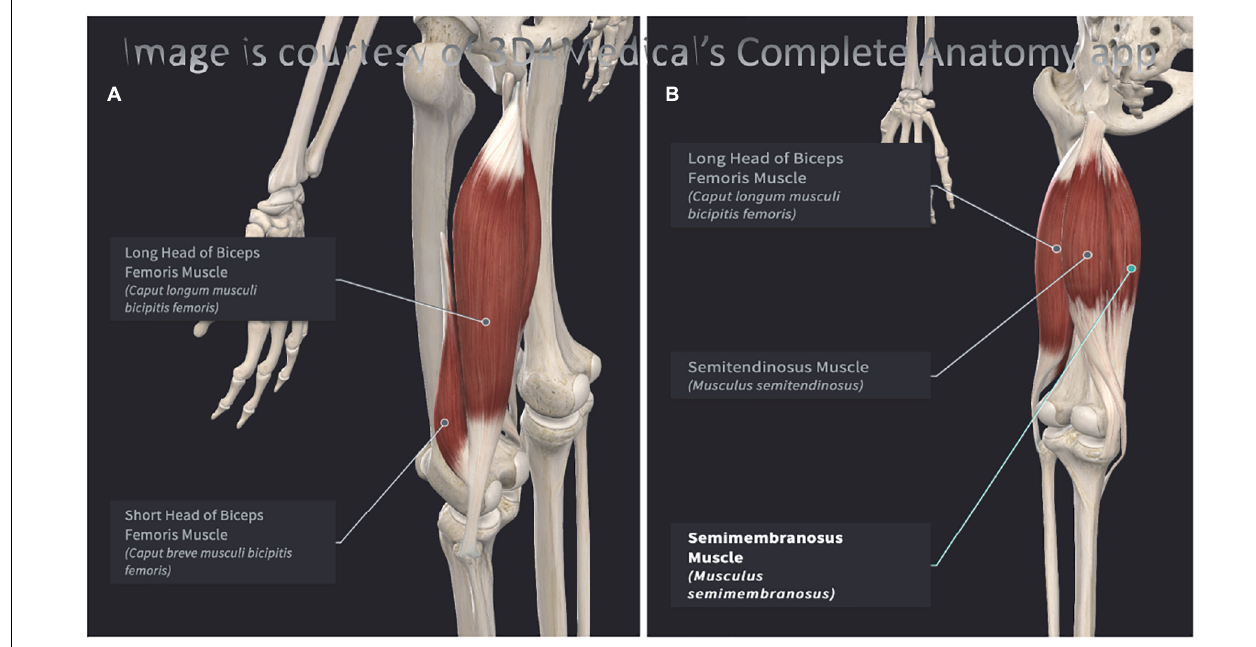
FIGURE 1 | (A) Posterolateral view of the left hamstrings. (B) Posteromedial view of the left hamstrings. Both images were elaborated with Complete Anatomy 2021, version 7.0.0. (desktop version for Mac OS) and reproduced here with permission (3D4Medical, Elsevier).